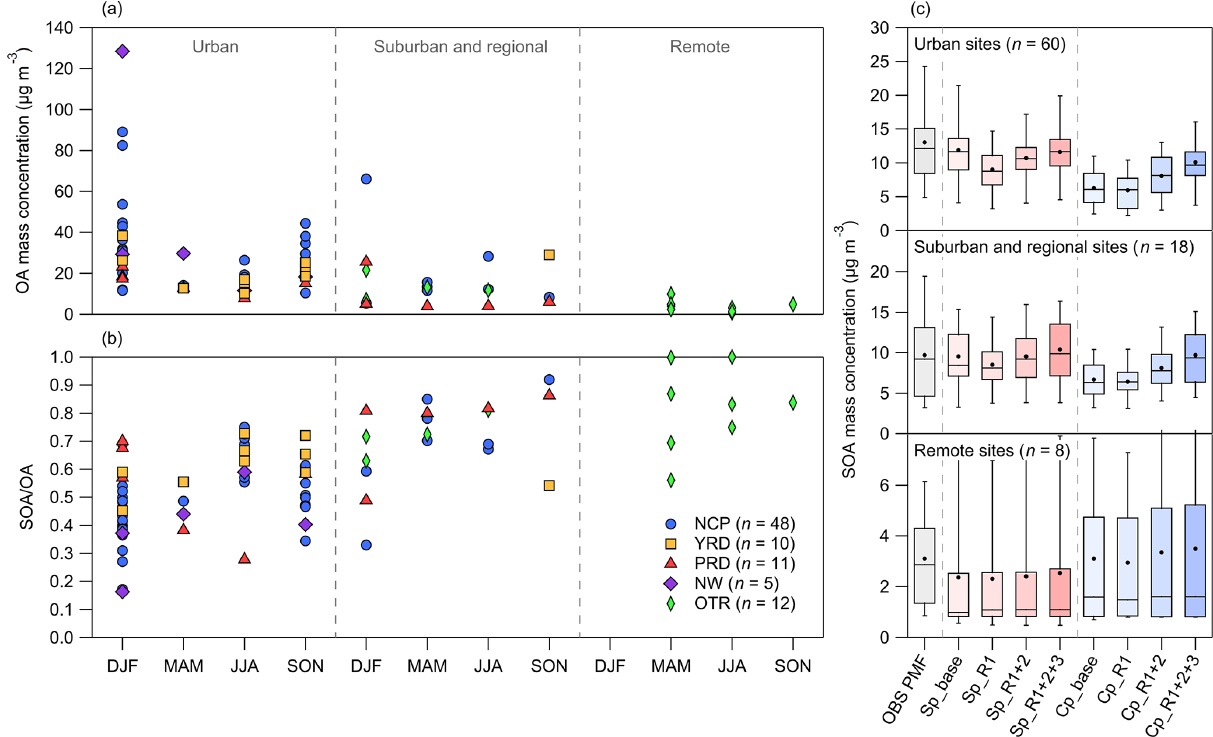
Figure 1. (a,b) The observed campaign-average mass concentrations of OA and the mass fraction of SOA in different seasons. (c) The box- and-whisker plots of the observed and simulated campaign-average mass concentrations of SOA. The upper and lower edges of the boxes, the whiskers, the middle lines, and the solid dots denote the 25th and 75th percentiles, the 5th and 95th percentiles, the median values, and the mean values of the SOA